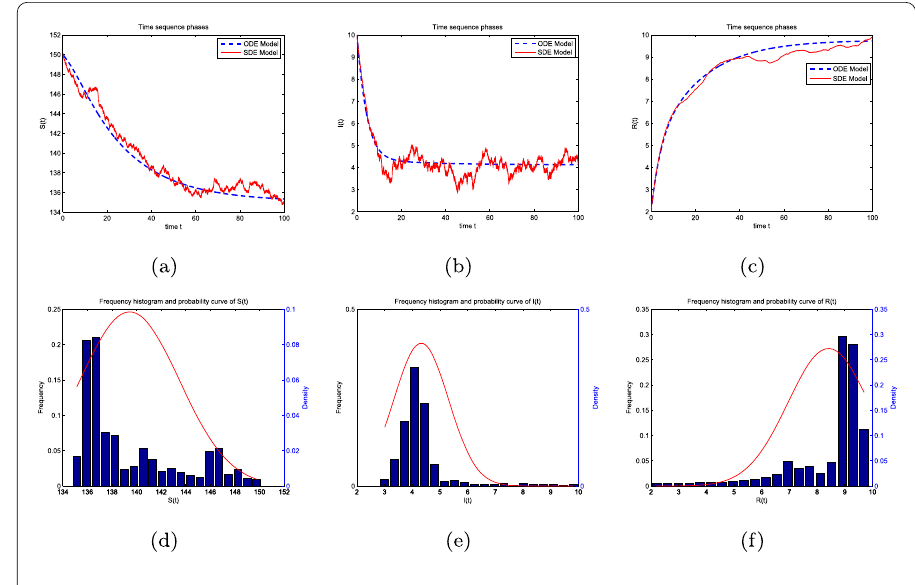
Figure 4 Dynamical curves of compartments: ( a ) S , ( b ) I , ( c ) R . The frequency histograms and marginal density functions of compartments: ( d ) S , ( e ) I , ( f ) R